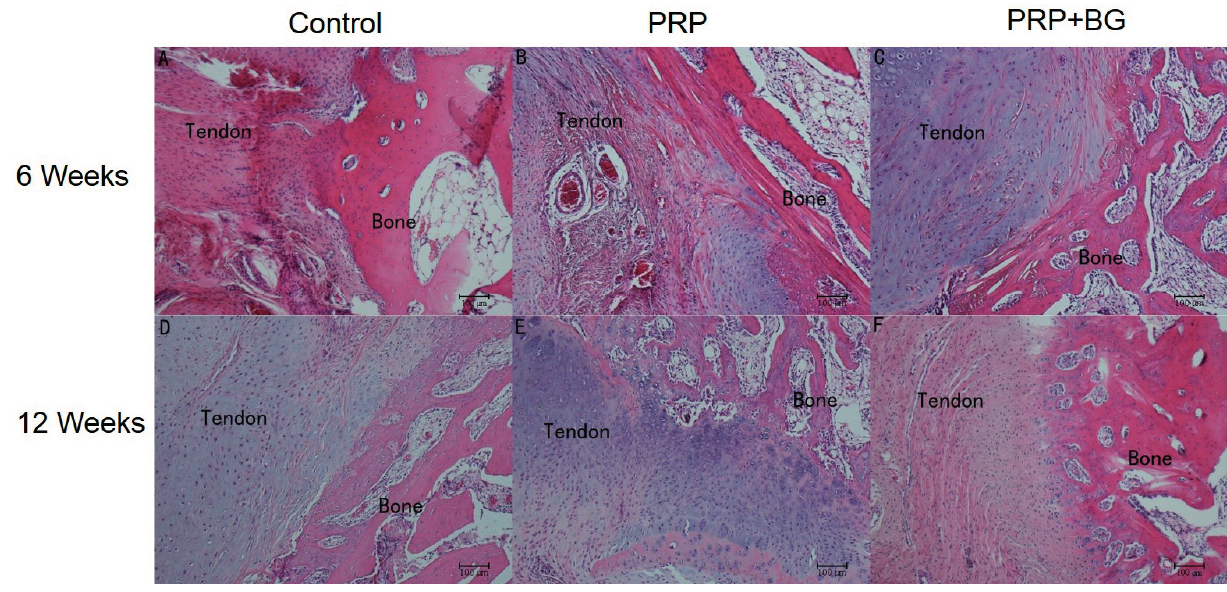
Figure 1. Histological characterization of the control, PRP (platelet-rich plasma), and PRP + BG (bioactive glass) group at 6 and 12 weeks post operation. Hematoxylin-eosin staining, ( A ) Control group 6 weeks; ( B ) PRP group 6 weeks; ( C ) PRP + BG group 6 weeks; ( D ) Control group 12 weeks; ( E ) PRP group 12 weeks; and ( F ) PRP + BG group 12 weeks, magnification